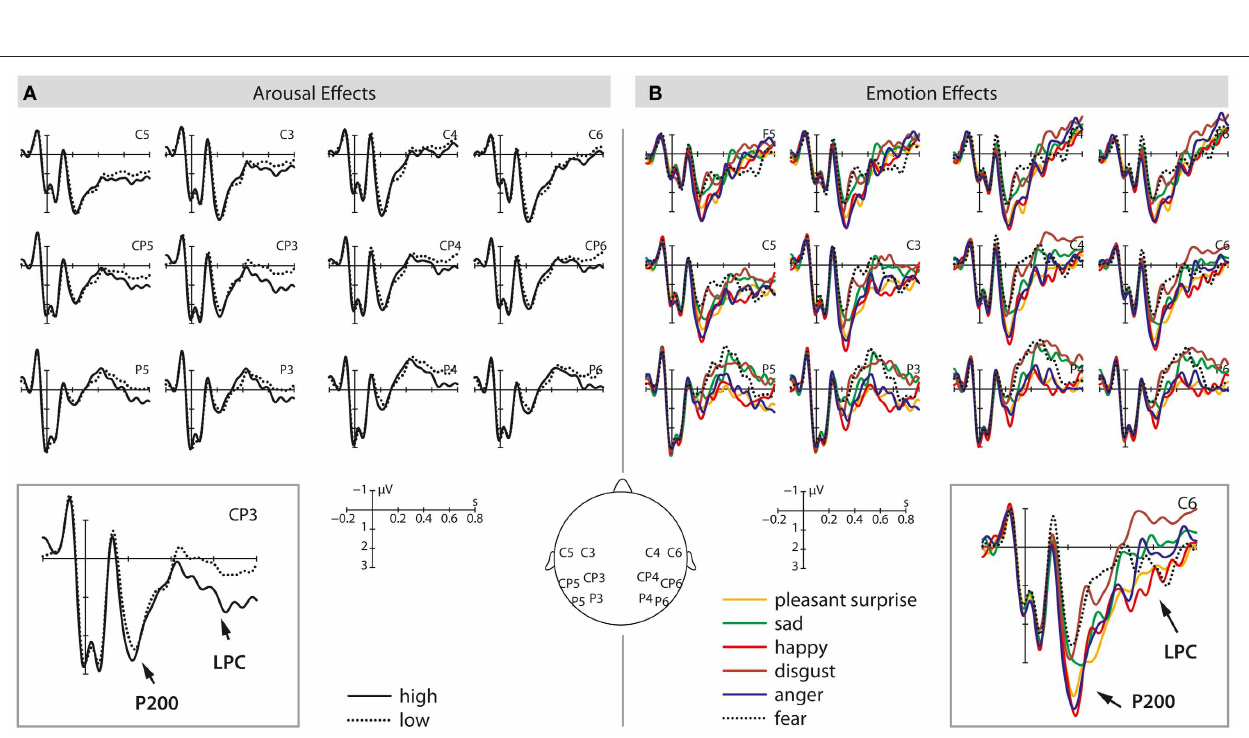
before stimulus onset up to 800ms after stimulus onset. On the right side, average waveforms for different emotional prosodies are displayed from 200ms before sentence onset up to 800ms after stimulus